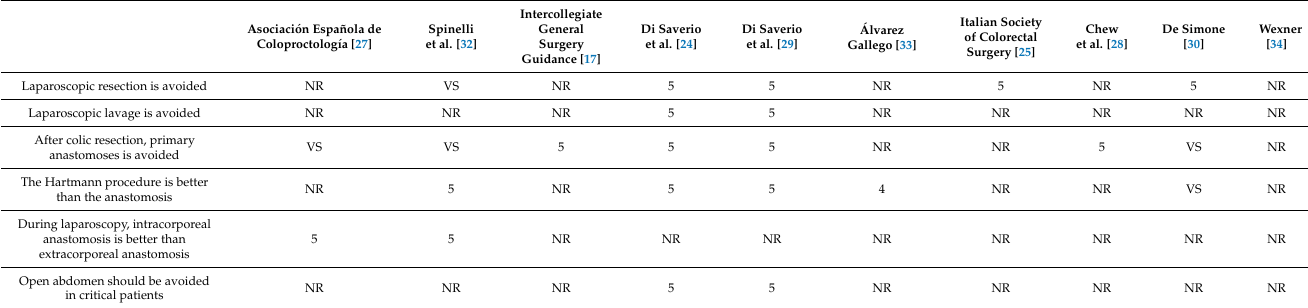
Table 7. Decision making in surgical treatment for complicated colonic diverticulitis during the COVID-19 pandemic. Asociaci ó nEspañolade Coloproctolog í